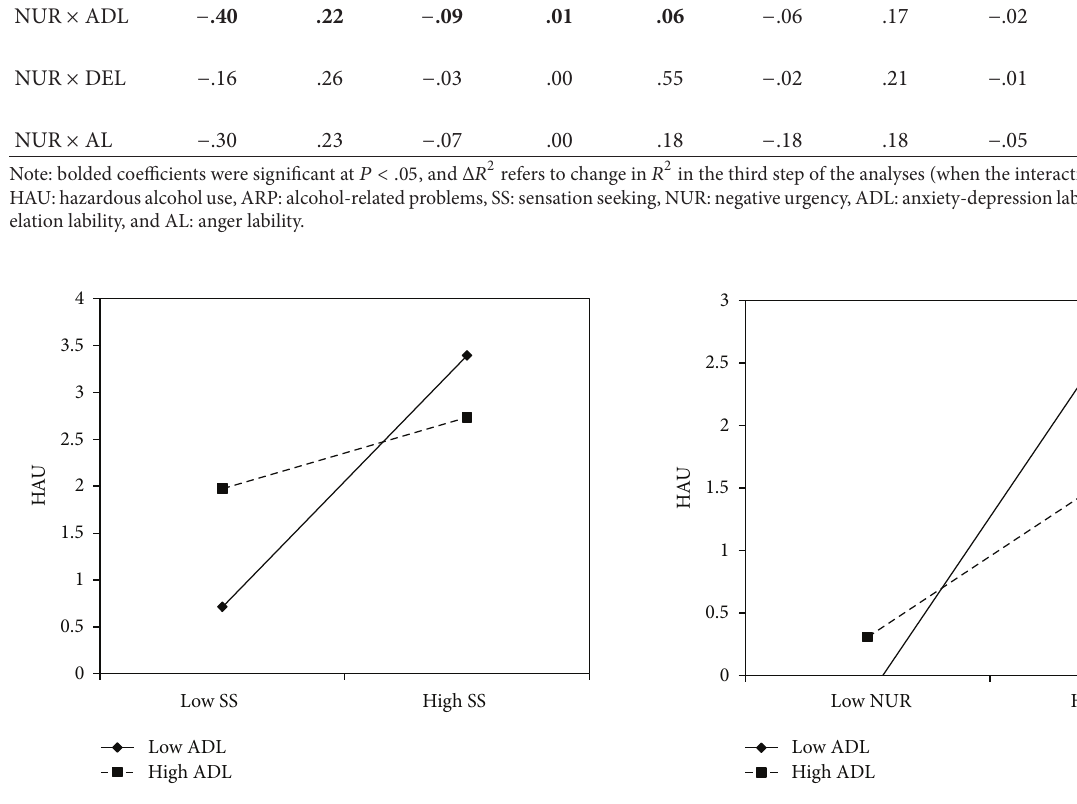
F 1: Anxiety and depression lability moderated the effect of sensation seeking on hazardous alcohol use among college students.